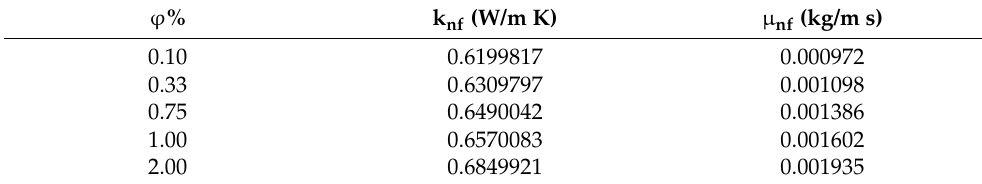
Table 4. Thermophysical properties of hybrid nanofluid [47].